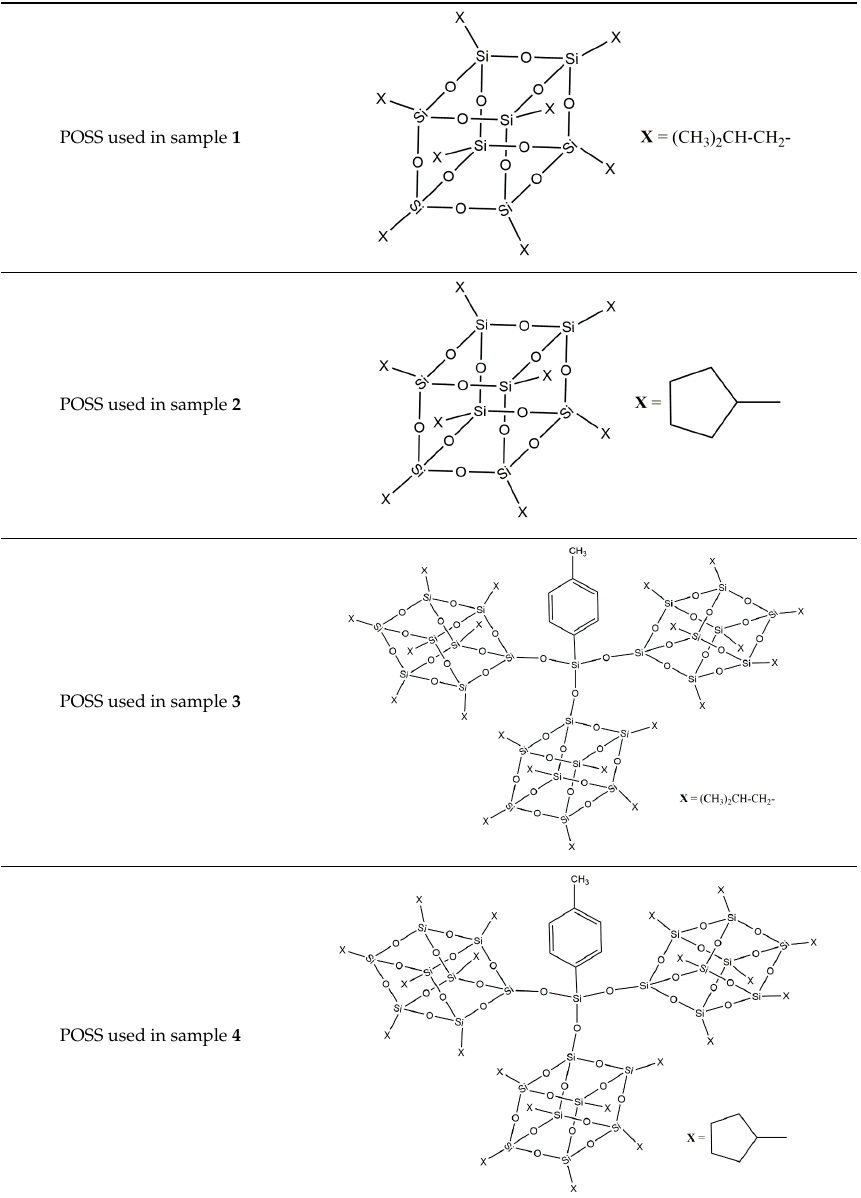
Table 1. Different POSSs structure used for reinforcing the studied nanocomposites.